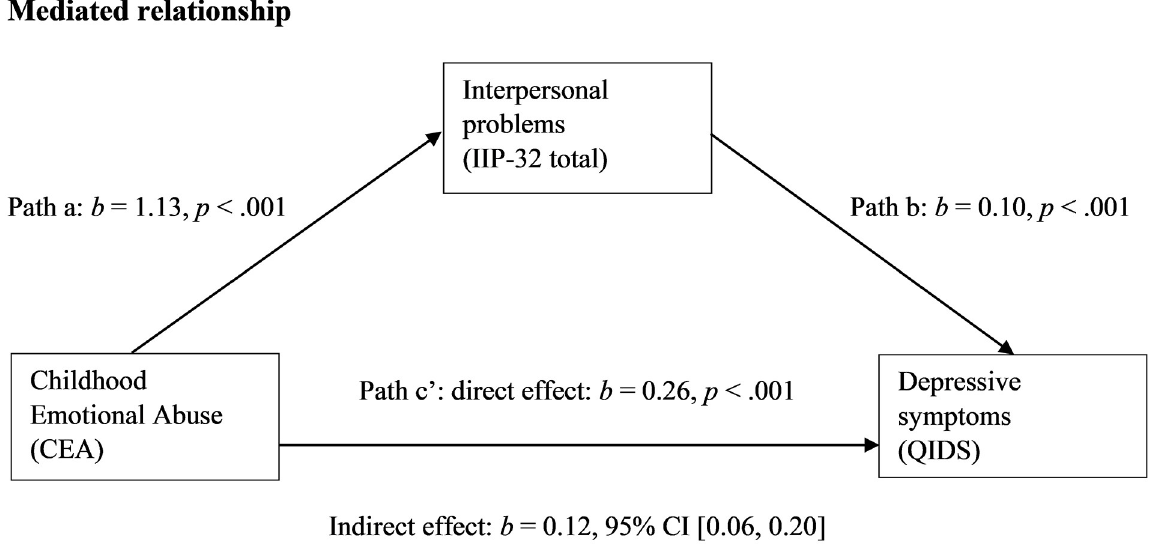
Fig 2. Model of childhood emotional abuse as predictor of depressive symptoms, mediated by interpersonal problems.